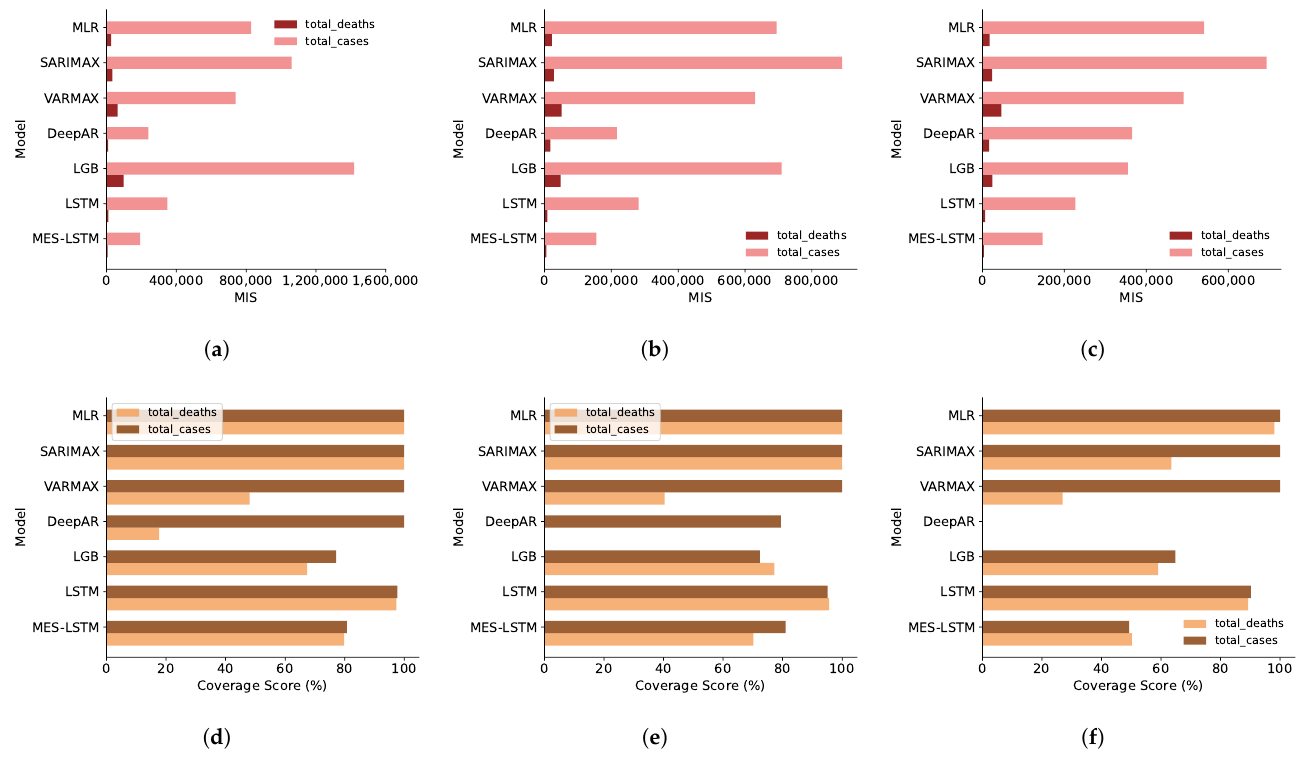
Figure 7. Prediction Interval Accuracy in South Africa. ( a ) MIS ( α = 0.05). ( b ) MIS ( α = 0.1). ( c ) MIS ( α = 0.2). ( d ) Coverage Score ( α = 0.05). ( e ) Coverage Score ( α = 0.1). ( f ) Coverage Score ( α = 0.2). Table 12. Student’s t-test for Forecast RMSE (H 0 : Benchmark Forecasts Outperform MES-LSTM).